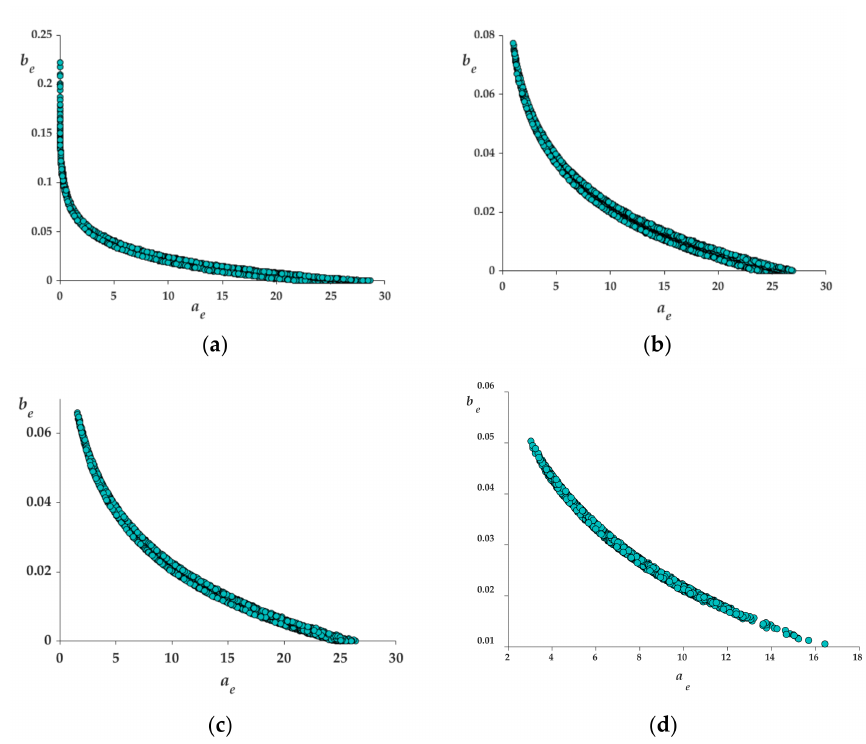
Figure 4. Relationship between the coefficients of the calibrated exponential empirical laws b e vs. a e : ( a ) m = 8; ( b ) m = 15; ( c ) m = 18; ( d ) m =